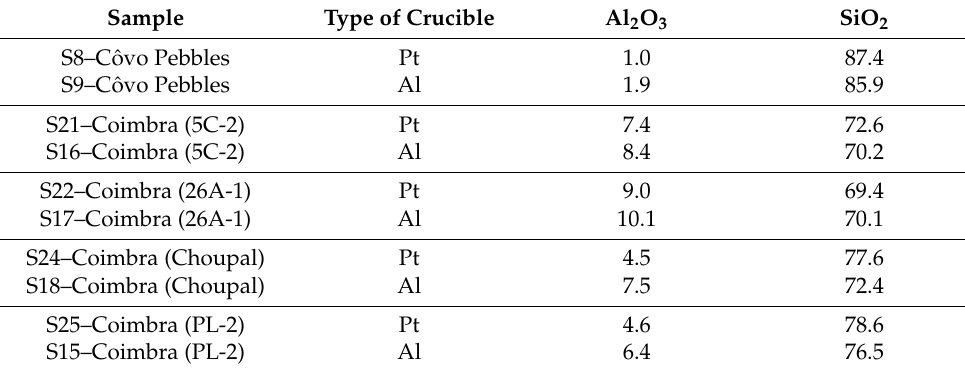
Table 2. Comparison between alumina and silica values for synthesised glasses employing sands and quartz pebbles, both melted in platinum (Pt) and alumina (Al) crucibles, to assess the influence of alumina in the glass, analysed using